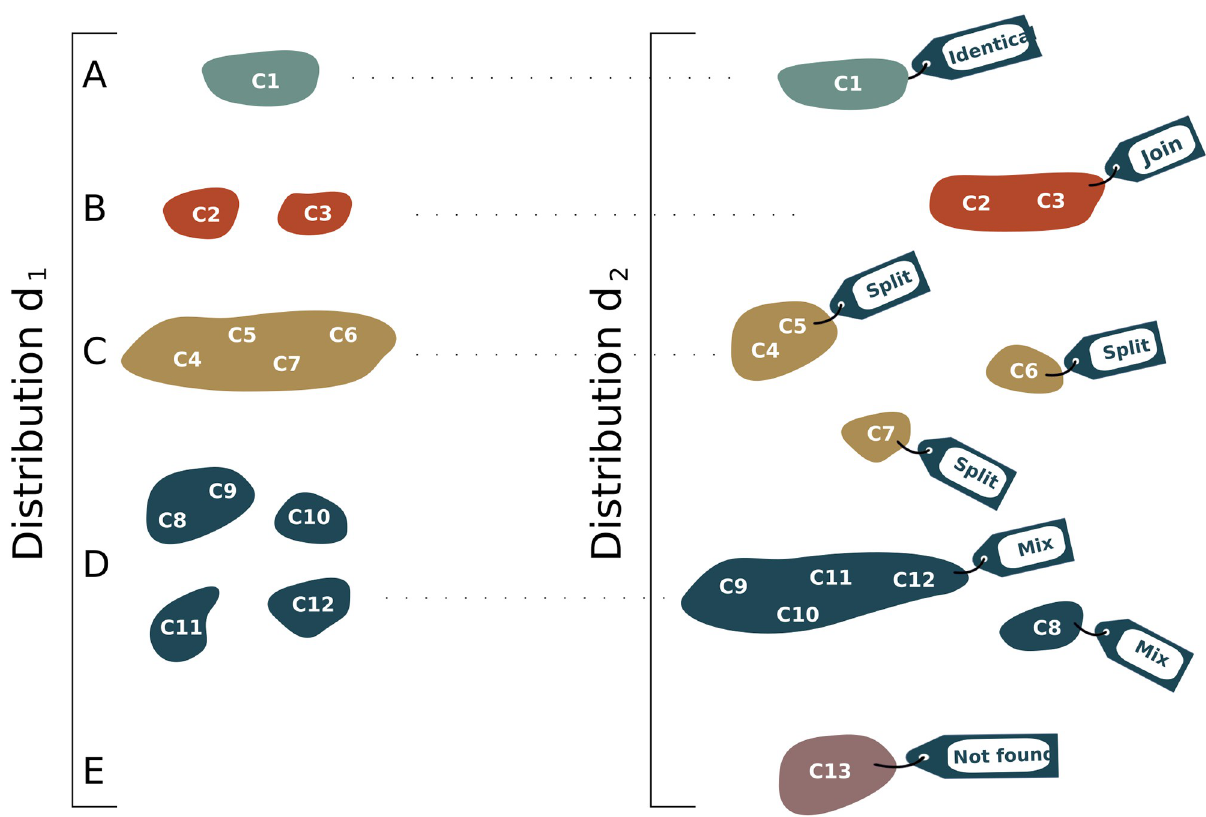
Fig 2. Clonal distribution comparisons. Five “events” describe the differences between two clonal distributions ( d 1 and d 2 ). The identical event counts the number of identical clonal lineages found in both distributions (a). The “join” event reports the number of clonal lineages in d 1 found merged in d 2 (b), while the split counts the number of clonal lineages in d 1 found separated in d 2 (c). The “mix” event is a mixture of these two later events (d), while “not found” reports the number of clonal lineages in d 2 not found in d 1 (e).